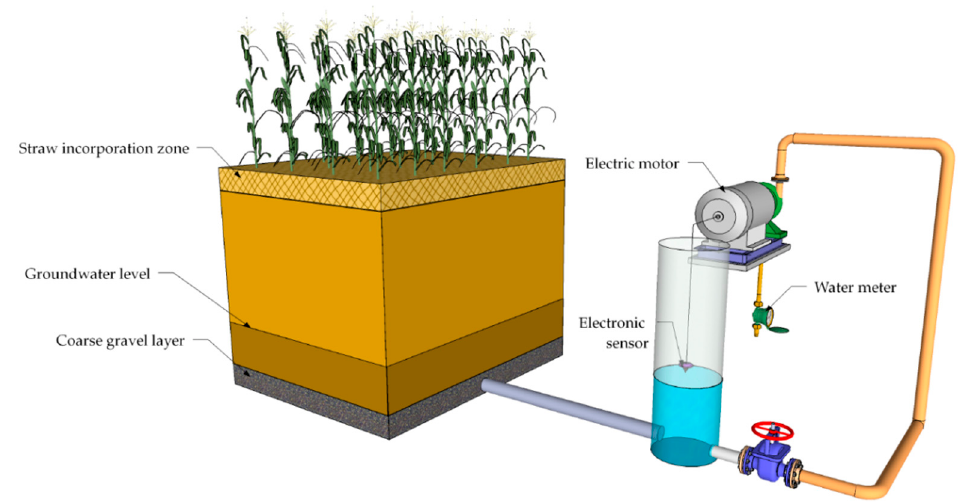
Figure 1. Sketch of the experimental lysimeter with the water level control system.